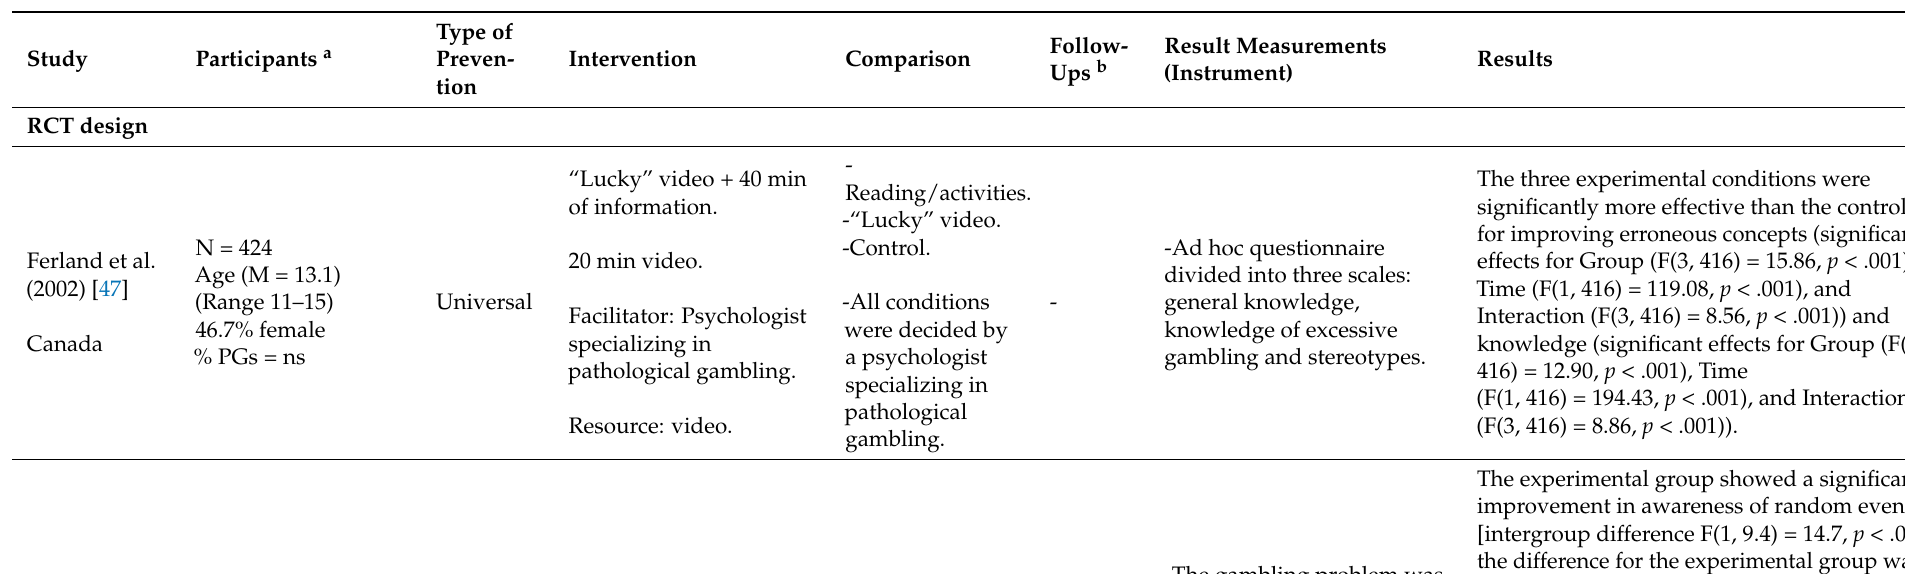
Table 1. Characteristics of the studies included in the